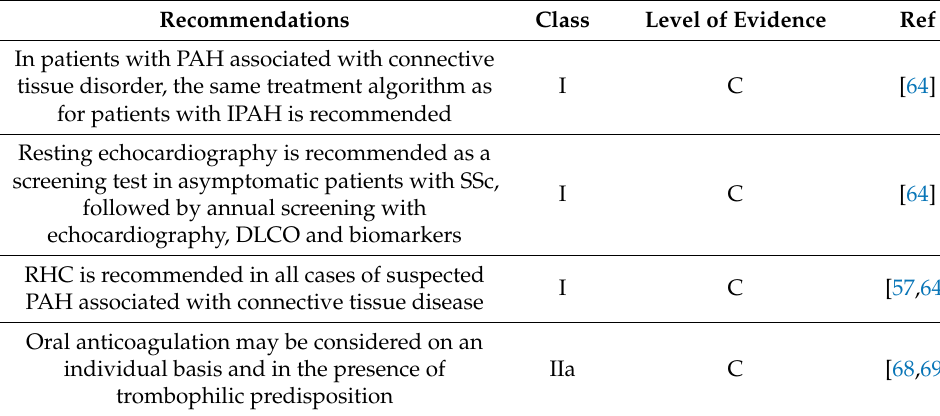
Table 5. Recommendations for the evaluation of patients with PAH and connective tissue dis- ease. Modified after [7]. Legend: DLCO, diffusing capacity for carbon monoxide; IPAH, idiopathic pulmonary arterial hypertension; PAH, pulmonary arterial hypertension; RHC, right heart catheteri- zation; SSc, systemic